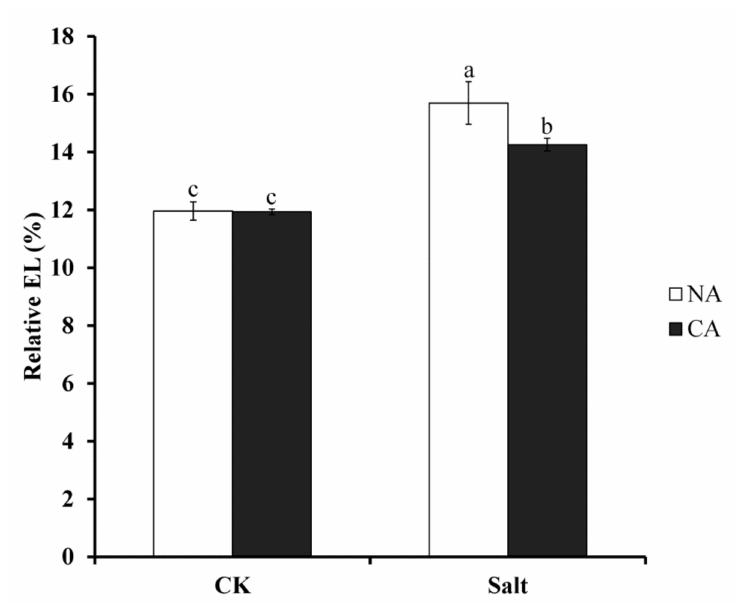
Figure 1. Electrolyte leakage (EL) in bermudagrass under di ff erent treatments. Mean values and standard deviation (SD) were calculated from three independent experiments. Di ff erent letters indicated significant di ff erence ( p < 0.05) based on one-way analysis of variance (ANOVA), Duncan’s multiple range test. Bars show SD. CK = control; NA = non-cold treatment; CA = pre-cold treatment for 6